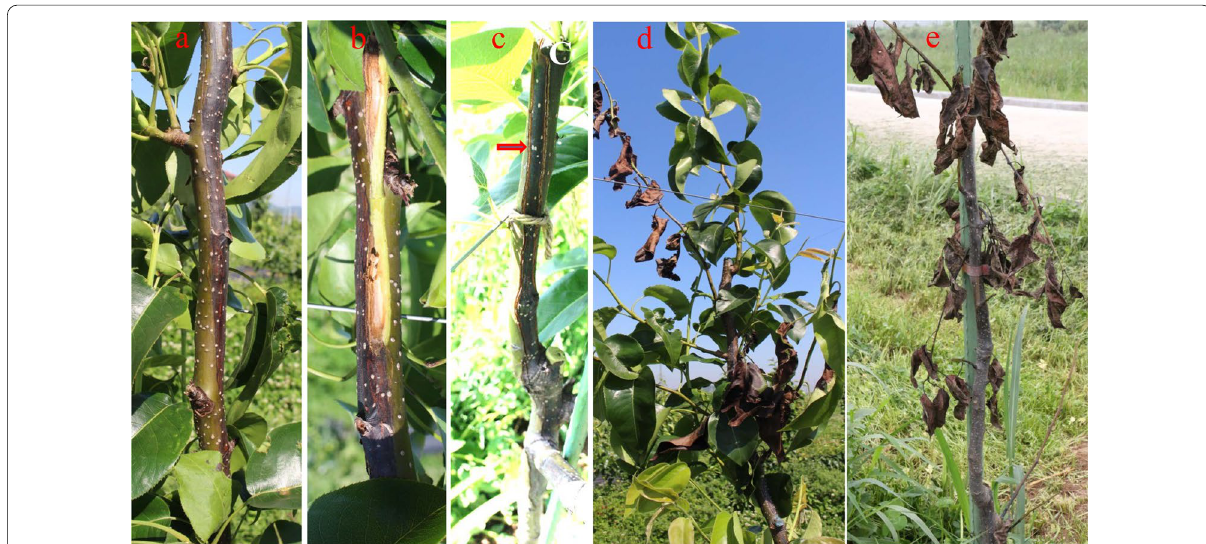
Fig. 1 Symptoms of pear stem canker and twig dieback disease in the field. a Stem canker on pear seedling. b Longitudinal section of stem canker. c Typical symptoms of stem canker in the field. d Twig symptoms on pear. e A dead tree caused by the disease. Red arrow indicates the typical flaw